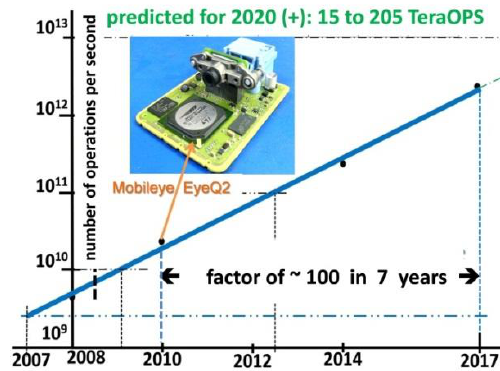
Figure 10. Computing power of specific vision systems [48].